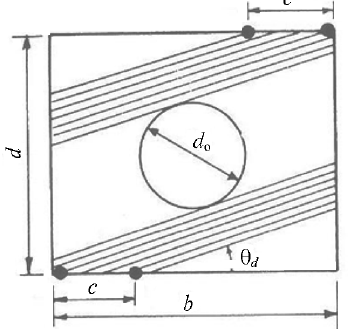
Fig. 5. Tension bands formed for circular holes